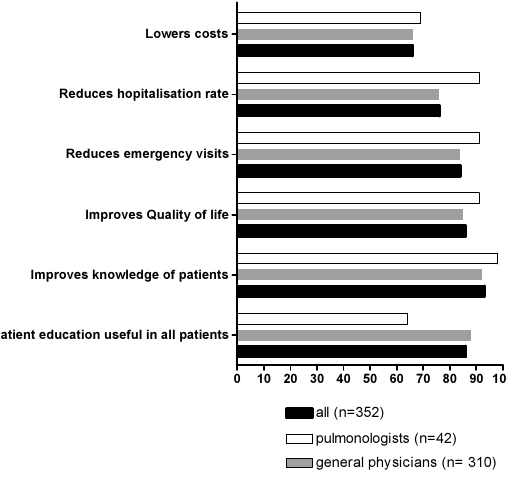
Figure 1 Knowledge about the effects of patient education in asthma